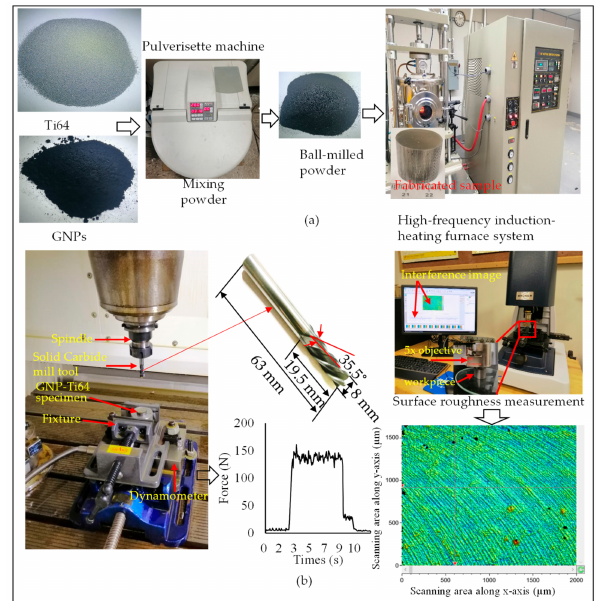
Figure 1. Experimental set-up and measuring devices ( a ) Preparation process for rapid fabrication of GNPs-Ti64 nanocomposite specimens ( b ) milling and measurements